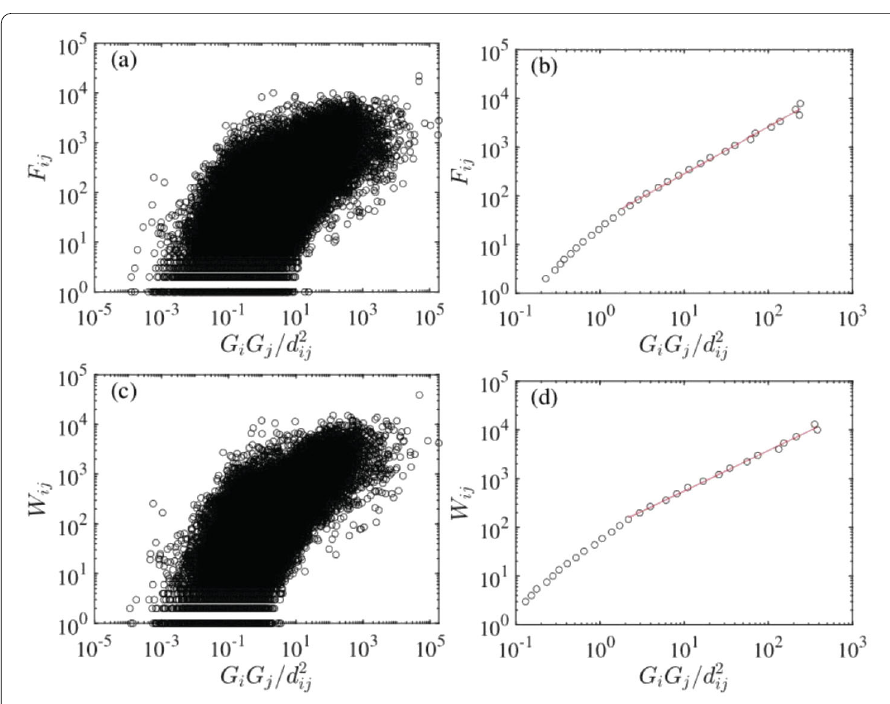
Figure 1 Testing the traditional gravity law with GDP for the directed and undirected freight highway transportation networks constructed over five months. ( a ) Scatter plot of F ij with respect to G i G j / d 2 directed network. ( b ) Binning plot of F ij with respect to G i G j / d 2